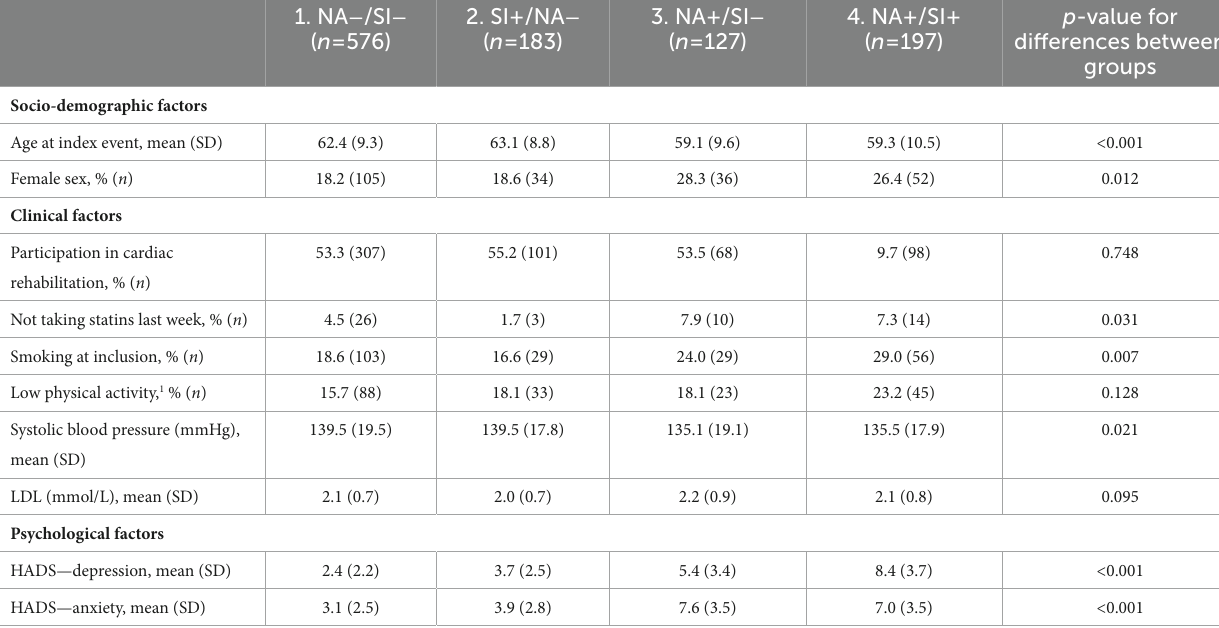
TABLE 3 A comparison of clinical and psychological factors in Type D